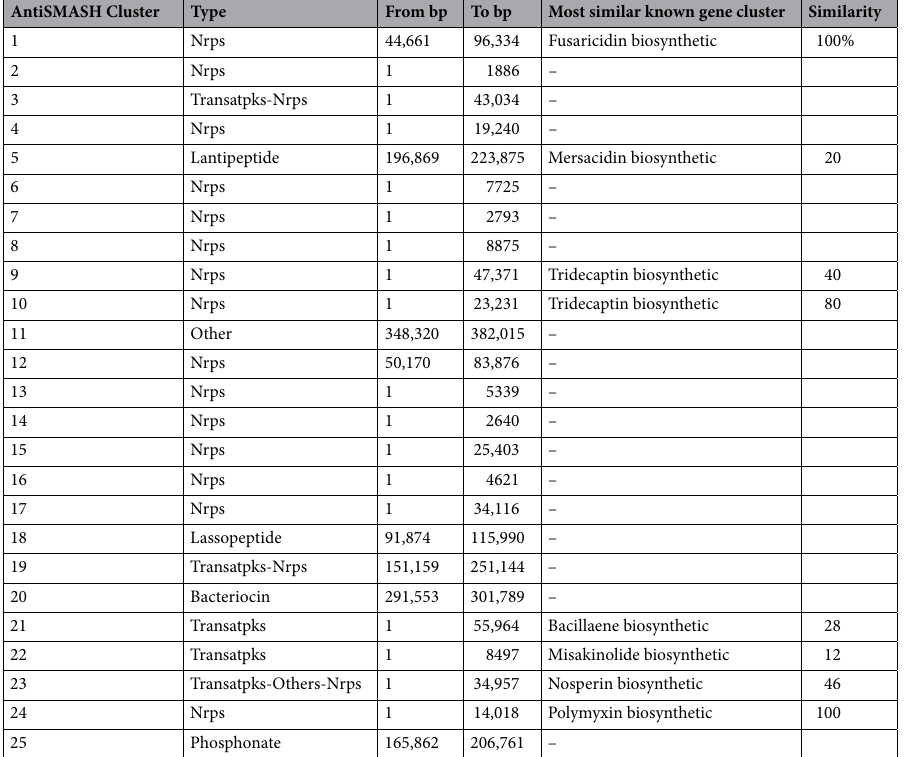
Table 4. JGI-ABC using AntiSMASH v 5.0 predicted the putative BGCs coding for antibiotics and secondary metabolites. The clusters include NRPS cluster such as transatpks, bacillaene, misakinolide, and nosperin biosynthetic; other unspecified ribosomally synthesized and post-translationally modified peptide product (RiPP) cluster; Transatpks-NRPS, and Lassopeptide cluster. (AntiSMASH cluster numbers, region, similarity % and similar known cluster are shown, – indicates which do not have similar cluster in the database).